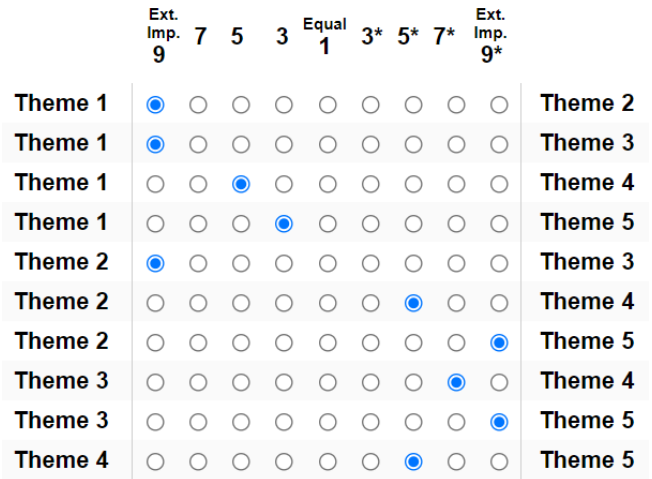
Figure 3. Example response to pairwise comparisons of the five CTs. When comparing (X with Y), ‘9’ , for example, indicates X is ‘Extremely Important’ compared with Y, while ‘9*’ indicates Y is ‘Extremely Important’ compared with